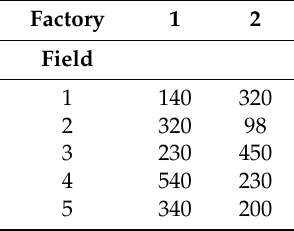
Table 7. Average population along connections of collecting centers to factories